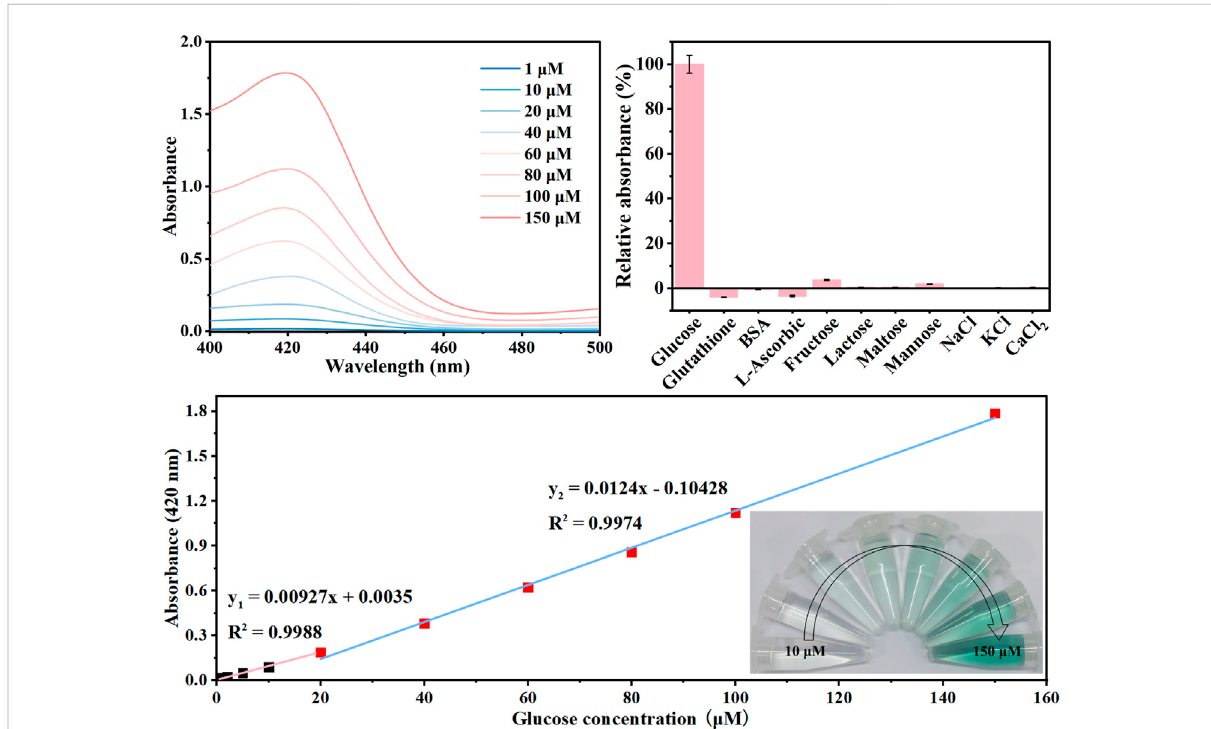
FIGURE 5 (A) UV-vis absorption data of solutions with the increase of glucose concentration from 1 to 150 μ M; (B) selectivity and anti-interference ability of GOx-HRP@hDFs for 100 μ M glucose in comparison to 1 mg/ml glutathione, BSA, L-ascorbic, 3 mM fructose, lactose, maltose, mannose, and NaCl, KCl, CaCl 2 . (C) plot of absorbance at 420 nm vs. the concentration of glucose. Inset: photographs showing visible detection of glucose in